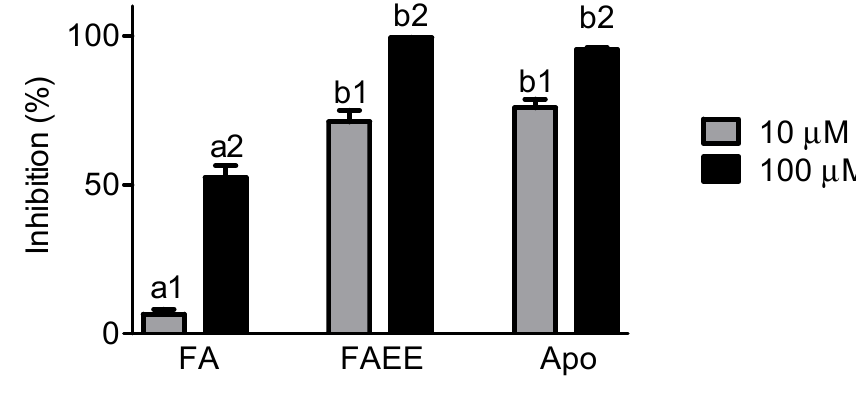
, b and c for 10 µM 1 1 1